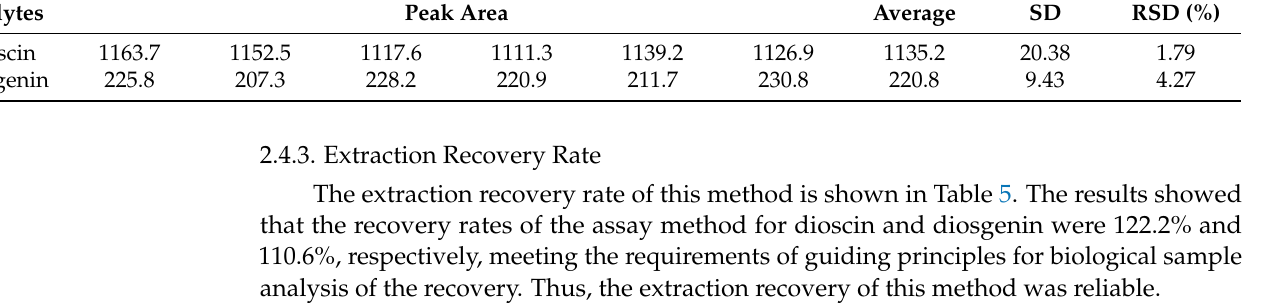
Table 5. Recovery rates of dioscin and diosgenin using HPLC ( n = 6).